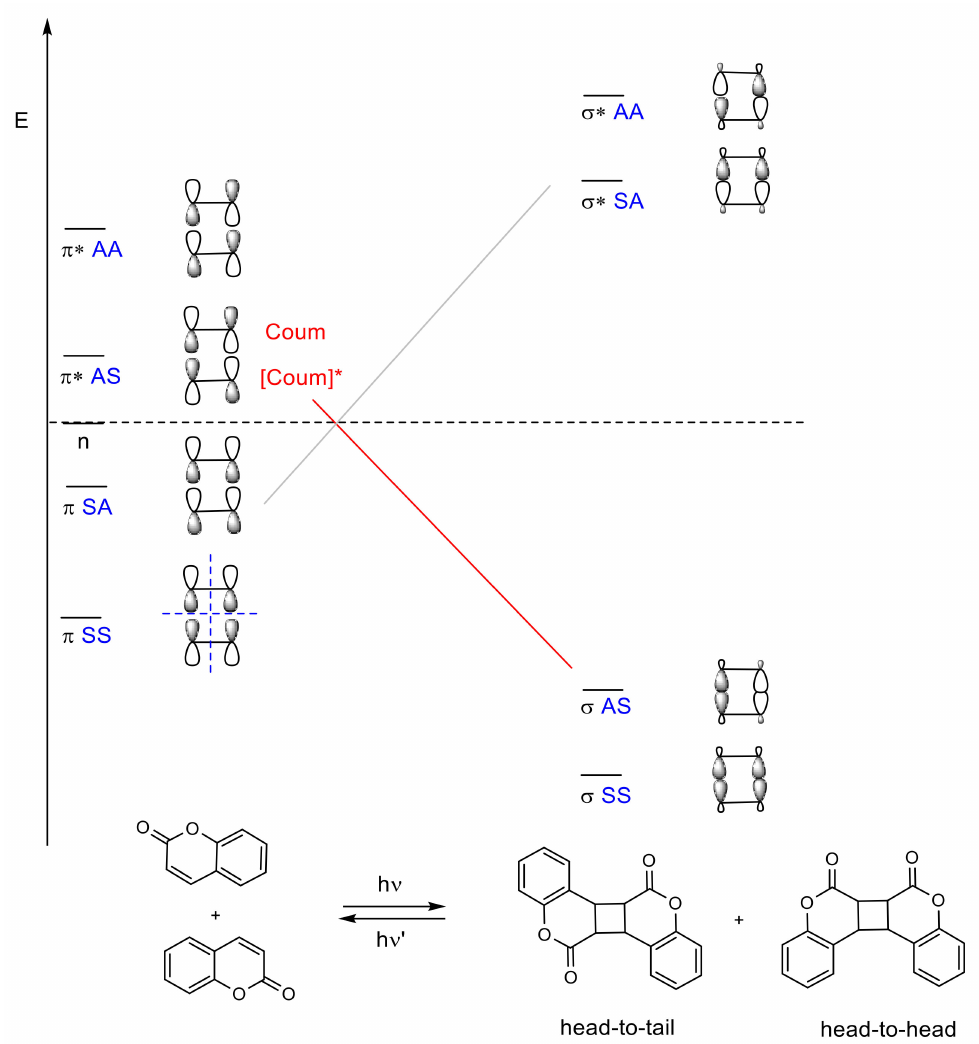
Figure 8. Energy and correlation diagram of the [2 π s + 2 π s] photodimerization of coumarin. The asterisk (*) denotes the excited state of the molecules.